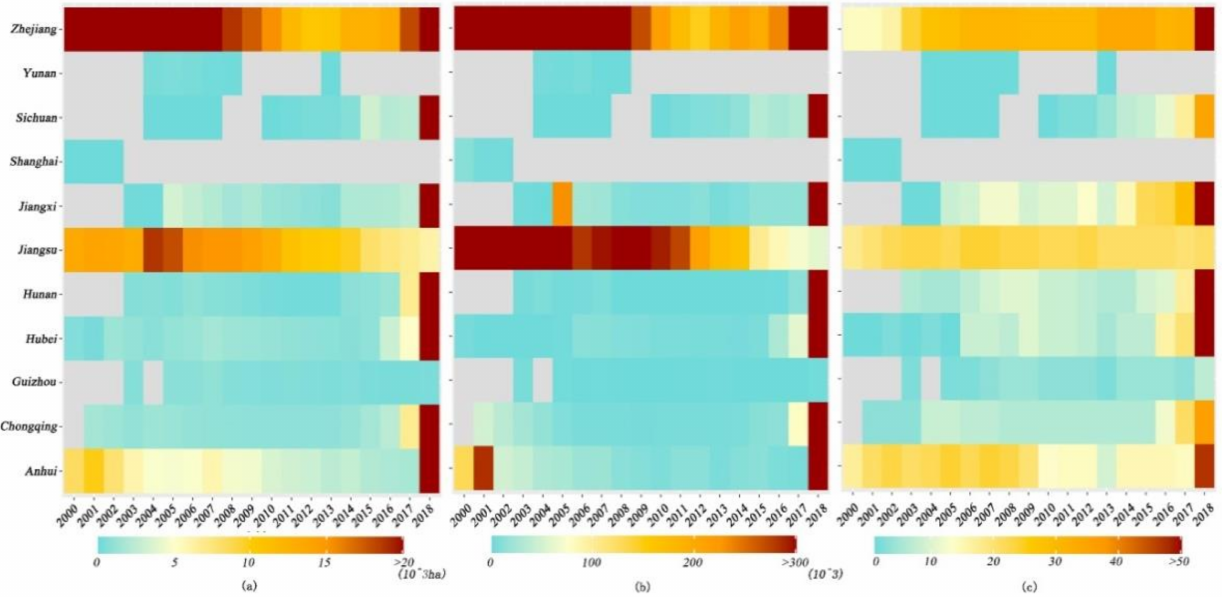
Figure 3. The time series changes of the provinces of the Yangtze River Basin from 2000 to 2018: ( a ) trends of the infested area in each province; ( b ) trends in the number of dead trees in each province; ( c ) trends in the number of affected counties in each province. (The horizontal axis represents the time, the vertical axis represents the name of the region, and the colours represent the disaster area, the number of dead trees and the number of affected counties in that year; thus, the changes of the PWD epidemic situation in each province can be seen